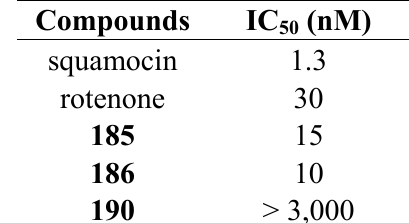
Table 14. Inhibition of complex